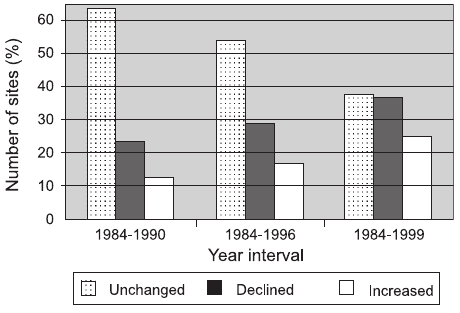
Fig. 5. Overall changes of the vegetation structure compared with the baseline condition.